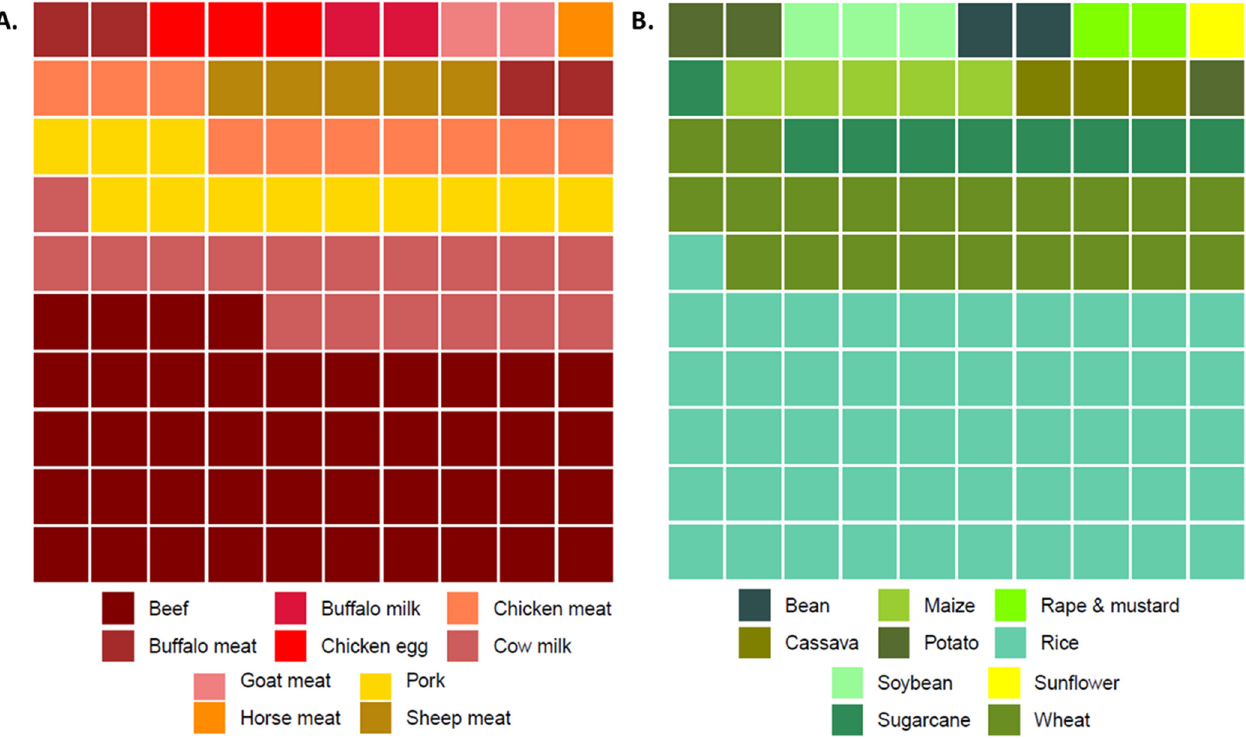
Figure 3. Top-contributing commodities for greenhouse gas (GHG) emissions by ( A ). animal-based foods and ( B ). plant-based foods. The figure was created using data from the study of Xu et al., 2021 [21]). The waffle plot shows the percentage of GHG emissions of the top ten plant-based and animal-based food commodities, where one tile represents 1%.